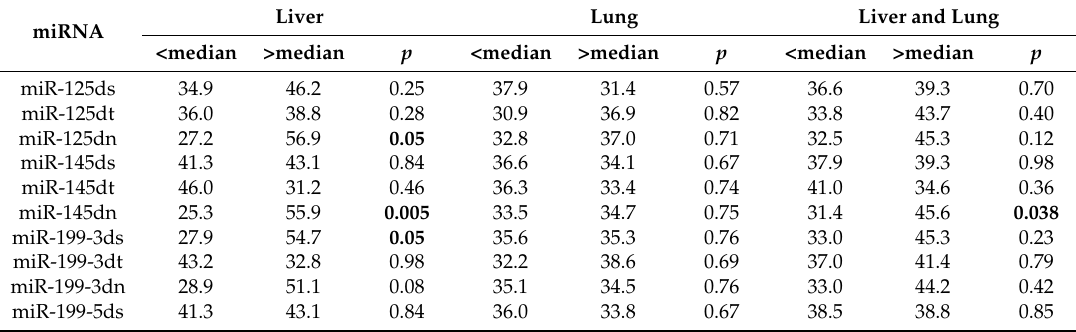
Table 4. Univariate analysis of overall survival (log rank). Significant p -values (<0.05) are written in bold (ds = stromal tissue, dt = tumor tissue, dn = normal tissue). miRNA